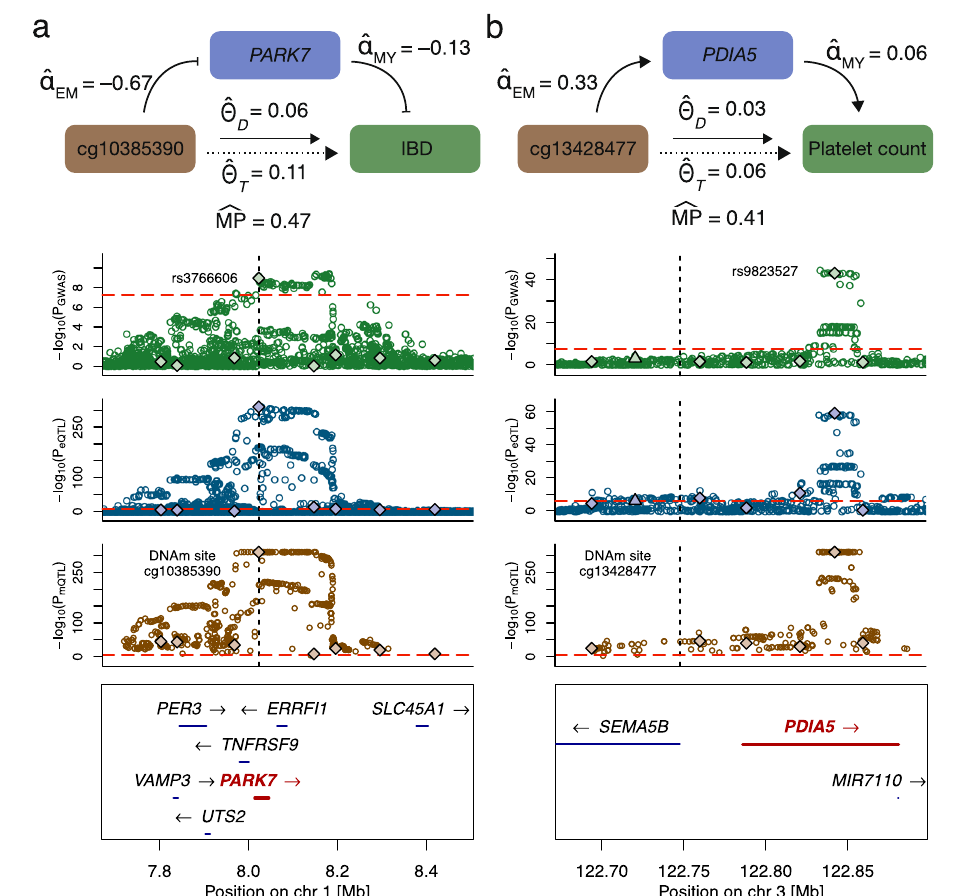
Fig. 5 | Plausible DNAm-transcript-trait regulatory mechanisms. a Mechanism involving DNAmprobe cg10385390, PARK7 and in fl ammatory boweldisease (IBD). b Mechanism involving DNAm probe cg13428477, PDIA5 and platelet count. The top row displays a schematic of the mechanism with estimated univariable (total effect ^ θ T ,DNAm-to-transcripteffect ^ α EM andtranscript-to-outcomeeffect ^ α MY )and multivariable(directeffect ^ θ D )MR effects (displayed mediation proportions( d MPs) are derivedfrom ^ θ D and ^ θ T estimates).The three following rowsshowthe regional SNP associations (-log 10 (p-values)) with the trait (GWAS, green), transcript (eQTL,